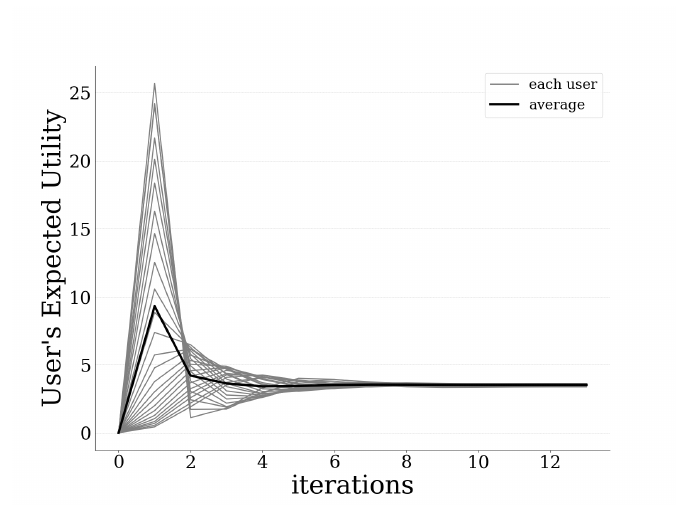
Figure 4. Expected utility of each user vs. iterations.